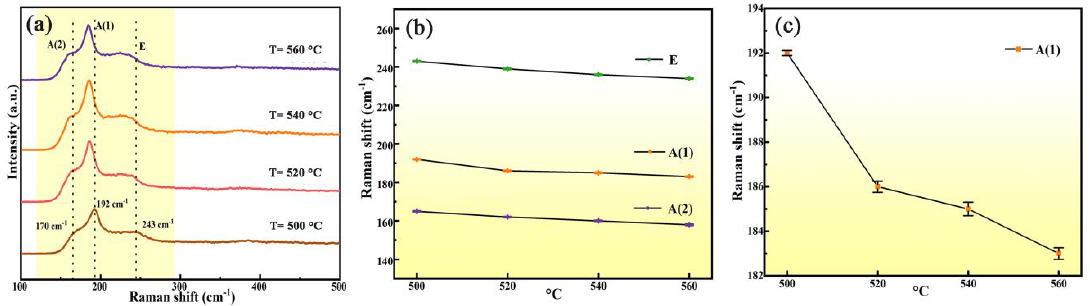
Figure 5. ( a ) Raman spectra of CNZTSSe films prepared at various selenization temperatures; ( b ) variation curve of three vibration mode peaks of CNZTSSe films with selenization temperature; ( c ) variation curve of main Raman vibration mode A (1) with selenization temperature.